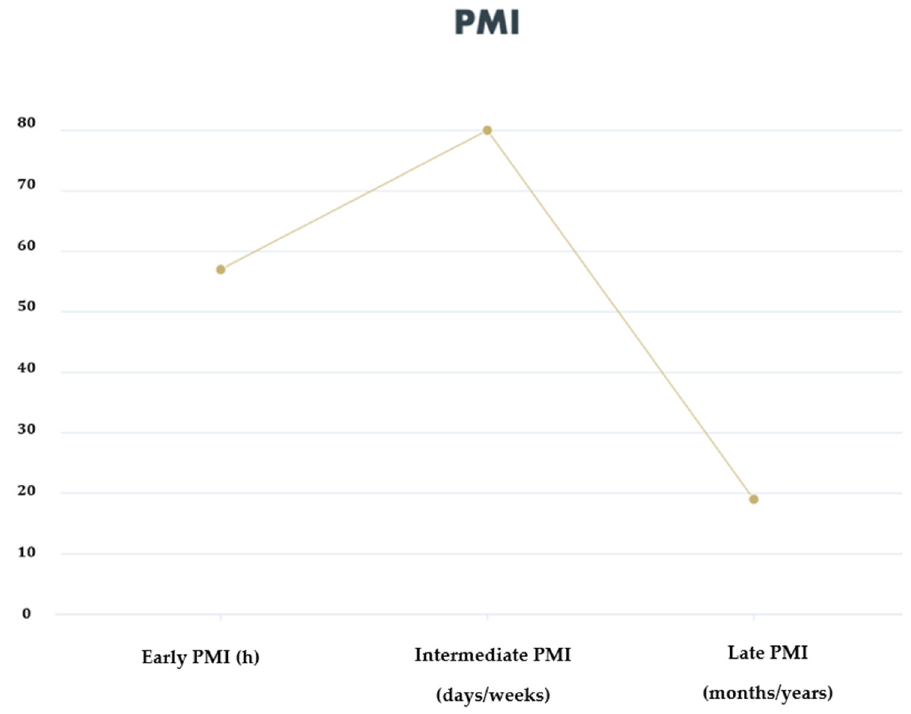
Figure 3. Overall percentage of studies that evaluated early, intermediate and late PMI. The most used methods were: Western blotting/immunoblotting in 27/47 (57.4%), mass spectrometry in 7/47 studies (14.8%), immunohistochemistry in 8/47 (17%), ELISA in 4/47 (8.5%) and other methods in 8/47 (17%) (Figure 4).